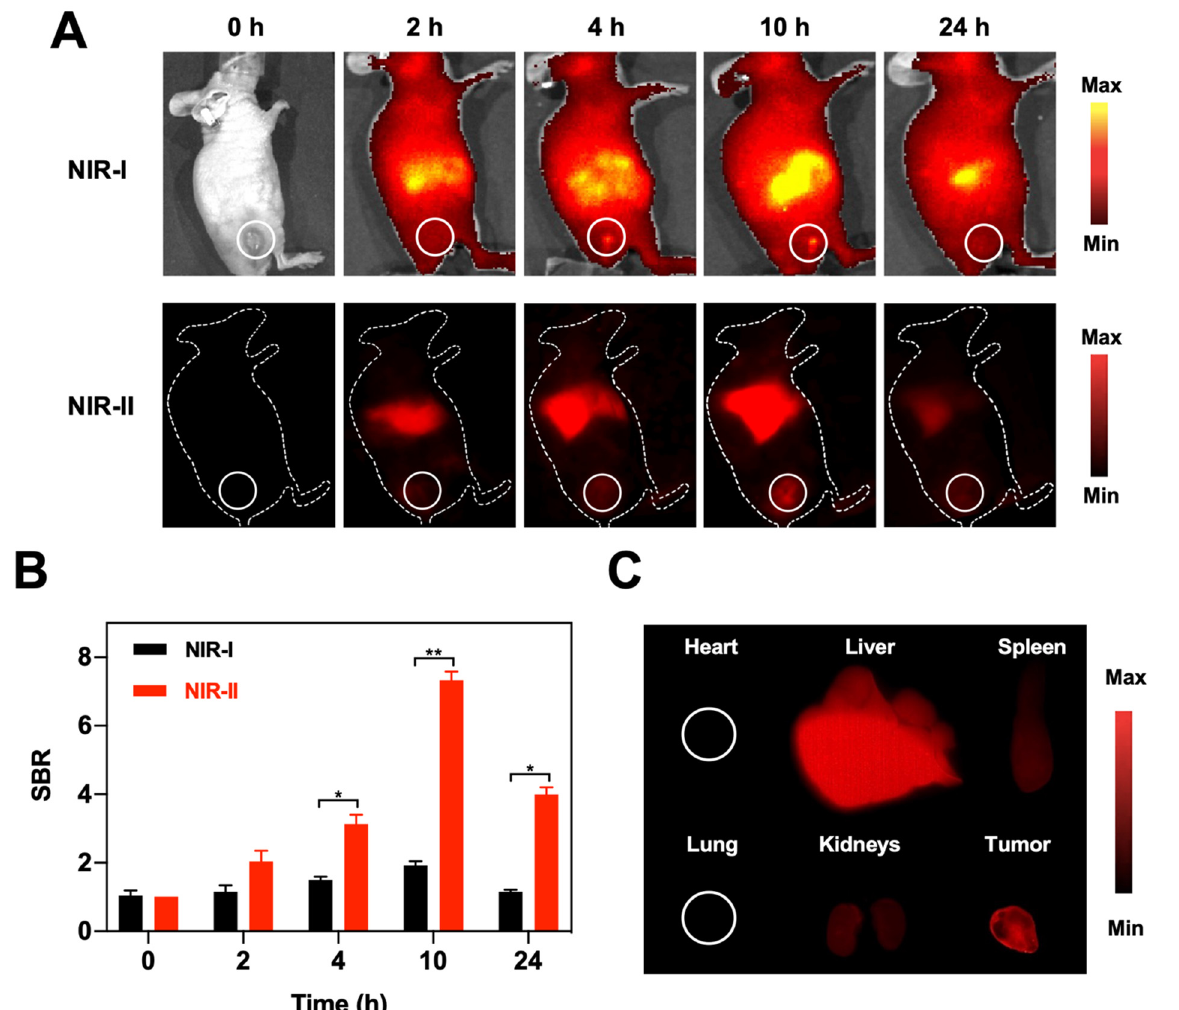
Figure 4. NIR-I and NIR-II FL imaging. ( A ) NIR-I and NIR-II FL images of 4T1 tumor-bearing mice at different time points (0, 2, 4, 10, and 24 h) post i.v. injection of BSA@Au. ( B ) SBR comparison between in vivo NIR-I FL and NIR-II FL images of 4T1 tumor-bearing mice. ( C ) The NIR-II FL images of main organs (heart, liver, spleen, lung, and kidneys) and tumor harvested from 4T1 tumor-bearing mice at 10 h post i.v. injection of BSA@Au. * p < 0.05, ** p < 0.01.